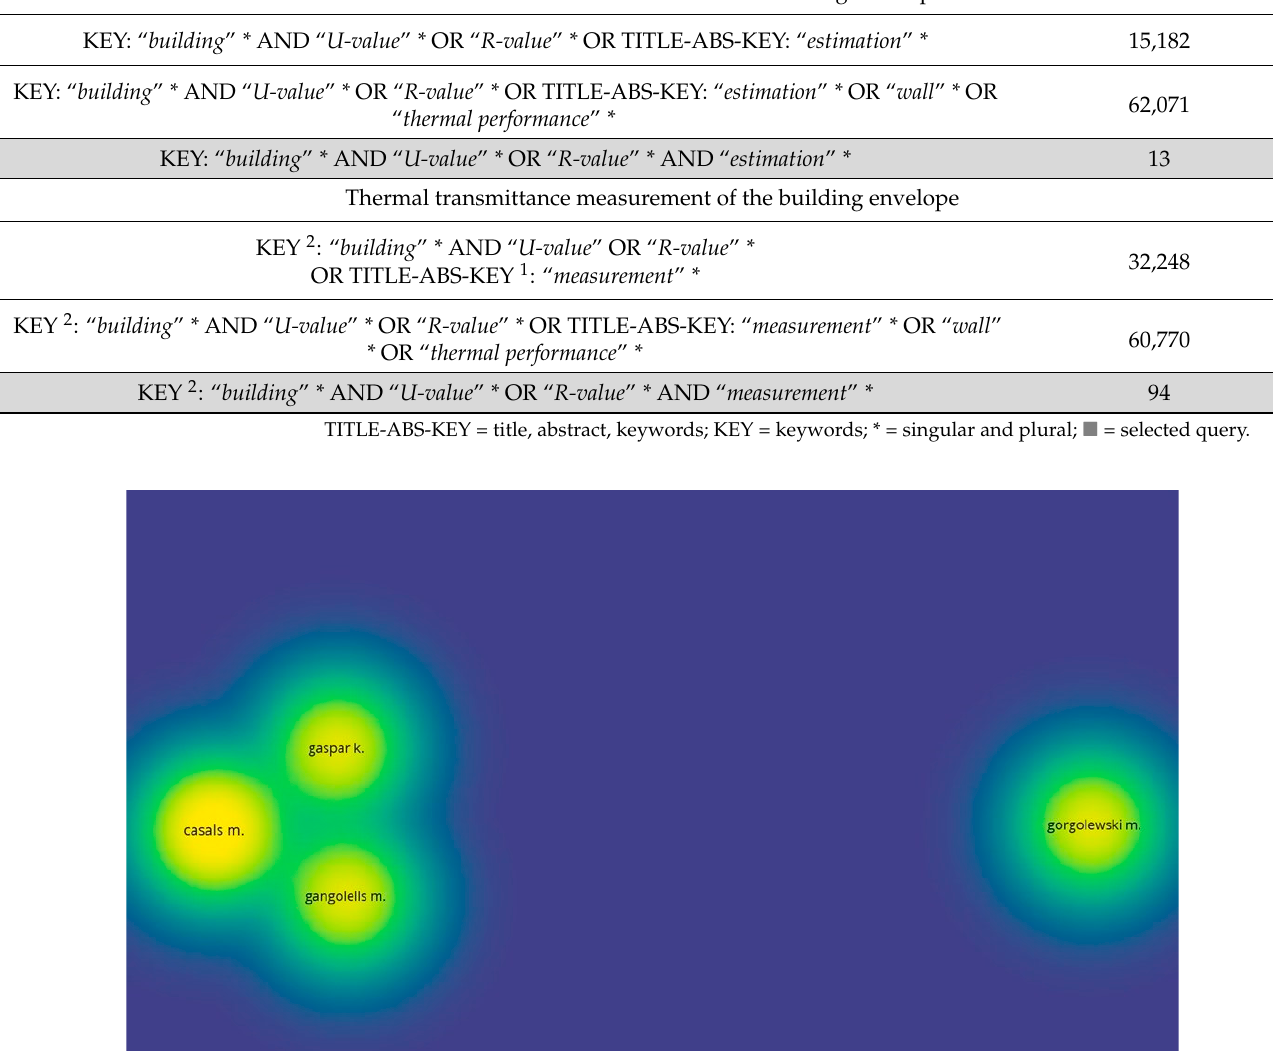
Thermal transmittance estimation of the building envelope